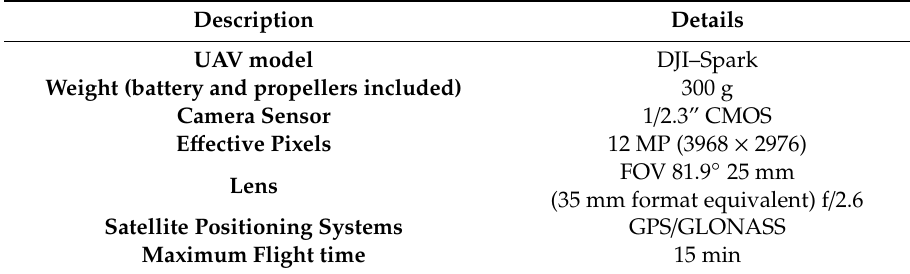
Table 1. Specification of DJI – Spark from the manufacturer [43].